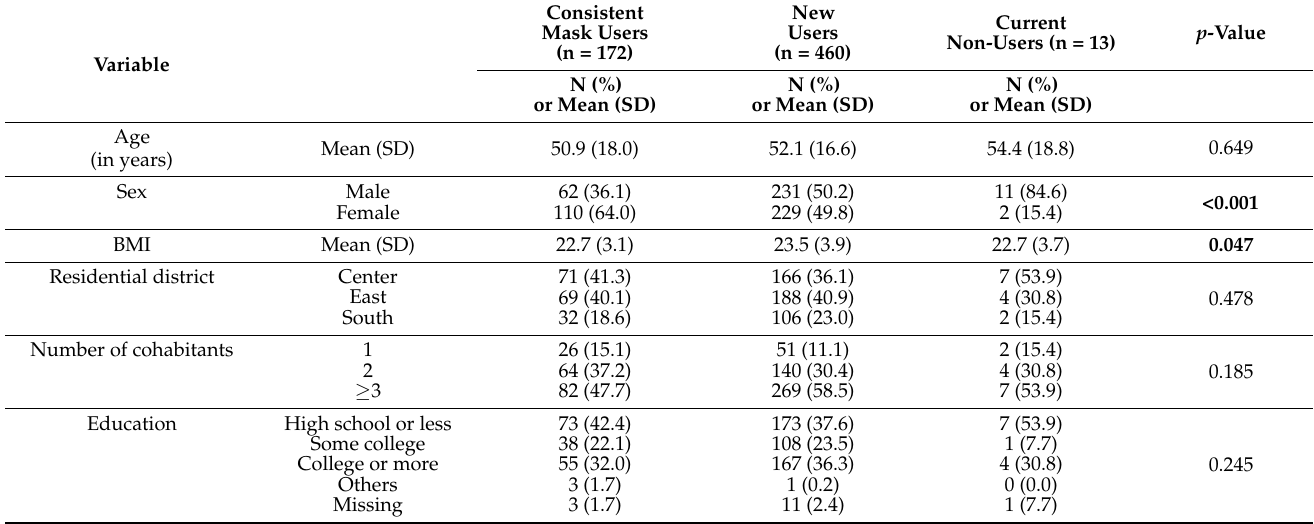
Table 1. Demographic characteristics of study participants by mask use behavior (n =